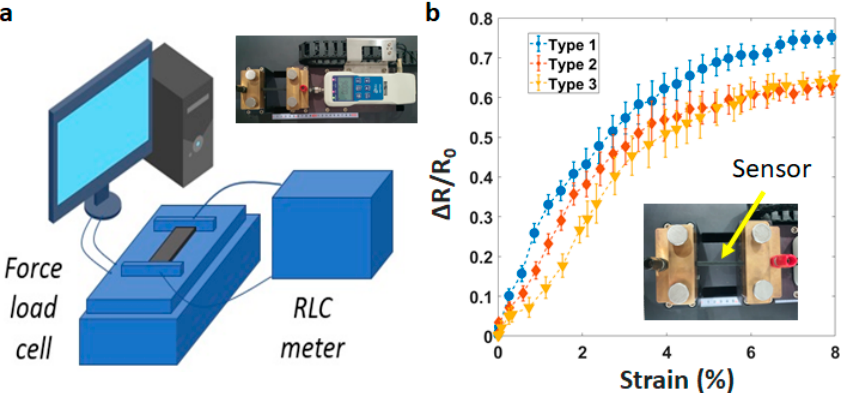
Figure 3. ( a ) Universal testing machine (UTM), ( b ) Sensitivity of the sensors with type 1—45°, type 2—90°, type 3—180°.